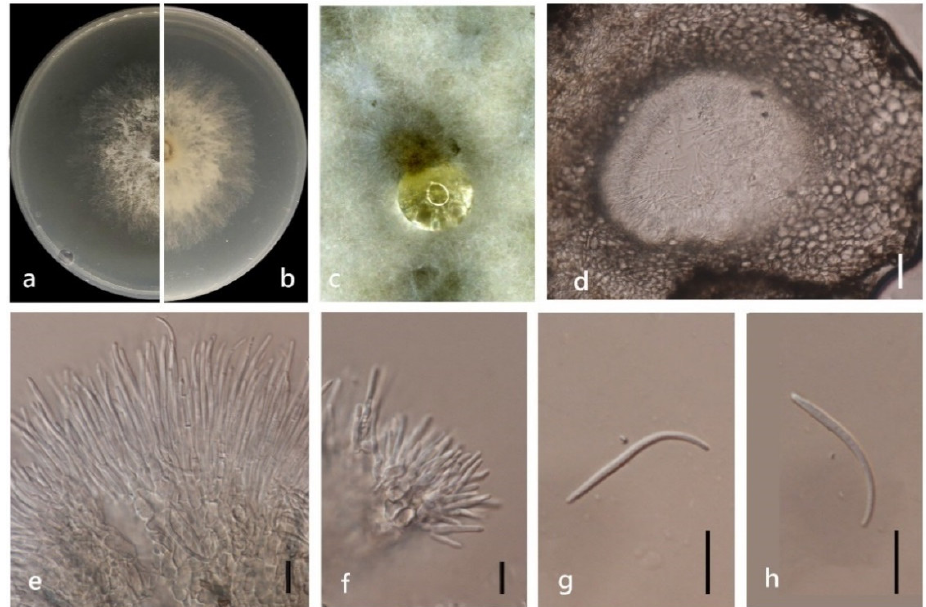
Figure 14. Diaporthe xishuangbanica (ZHKUCC 22-0054) ( a ) upper view of colonies on PDA; ( b ) Reverse view of colonies on PDA; ( c ) Pycnidia with conidial droplets on PDA; ( d ) Section of pyc-